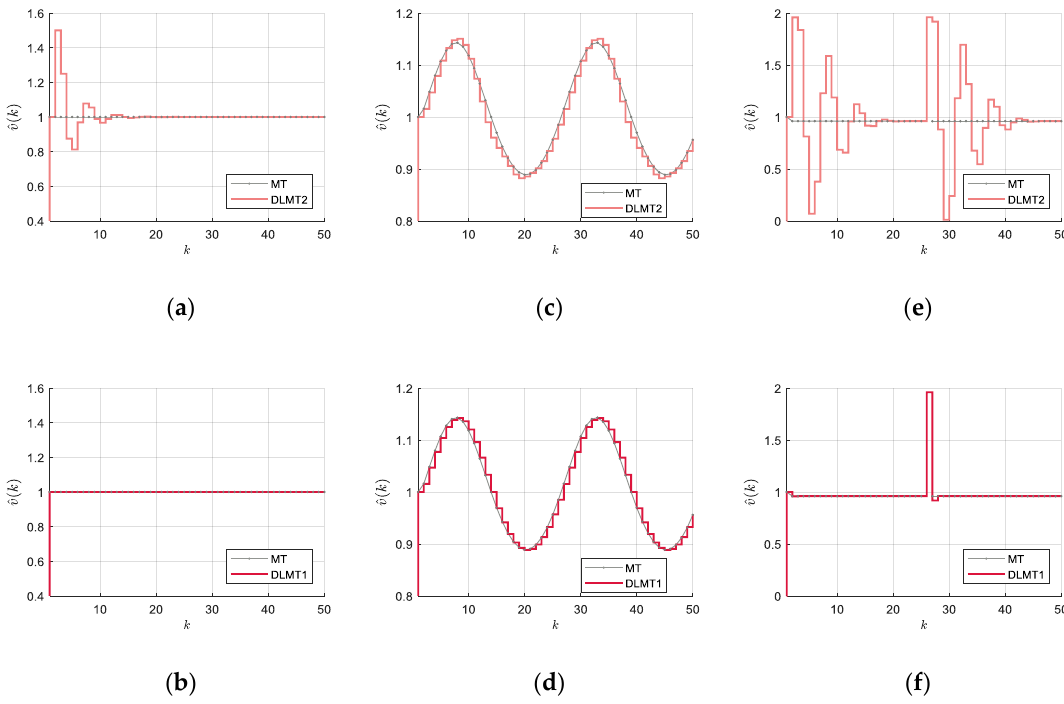
Figure 8. Comparison of step responses of the DLMT2 filter (top row) and the DLMT1 filter (bottom row) in the following cases of (organized in the three columns): i) Constant δt ( a ), ( b ), ii) Sinusoidal variation of δt ( c ), ( d ), and iii) Sawtooth variation of δt ( e ), ( f ).